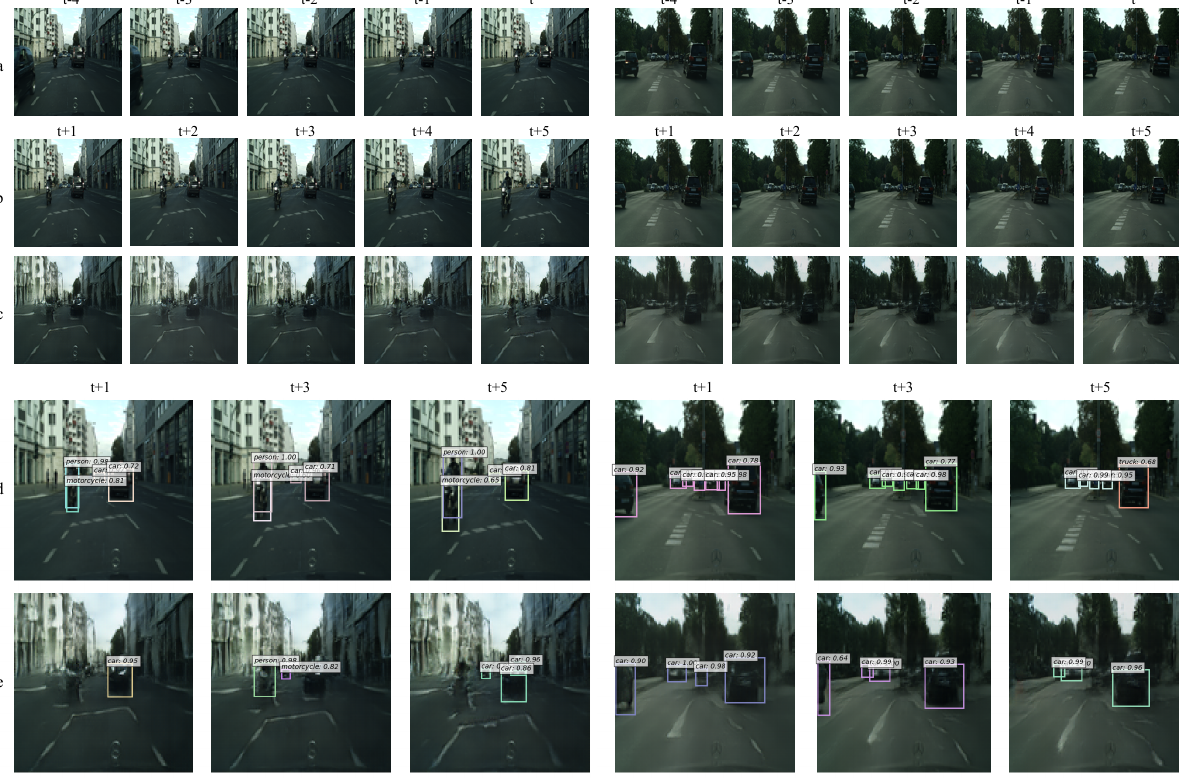
Figure 6. Prediction results for the Cityscapes test sequences. a: Input, b: Ground Truth, c: FutureGAN (ours), d: YOLOv3 detections on the Ground Truth, e: YOLOv3 detections on the FutureGAN results. The Average Precision (AP) for the class "car" of the YOLOv3 detections on the first 1000 videos of the Cityscapes test split is 42.21% (Predicted frame 1: 46.45%, 2: 45.92%, 3: 43.50%, 4: 39.86%, 5:35.63%). To calculate the AP we took the detections on the ground truth frames as the ground truth bounding boxes. 128 × 128 px frame resolution, following the procedure of